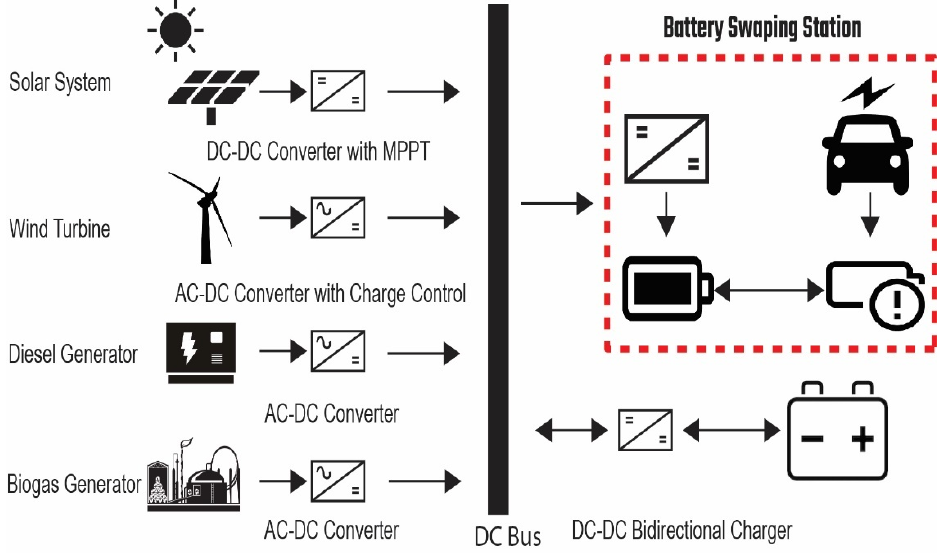
Figure 5. Standalone plugin electric vehicle charging station with swappable energy storage.